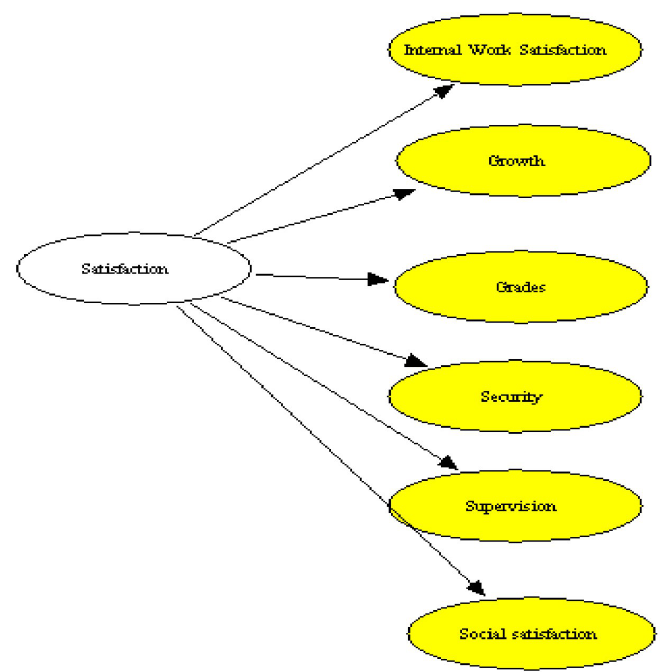
Figure 1b. Satisfaction Models tested. Multi-factor/multi-item scale (items of scales are not included in the diagram)